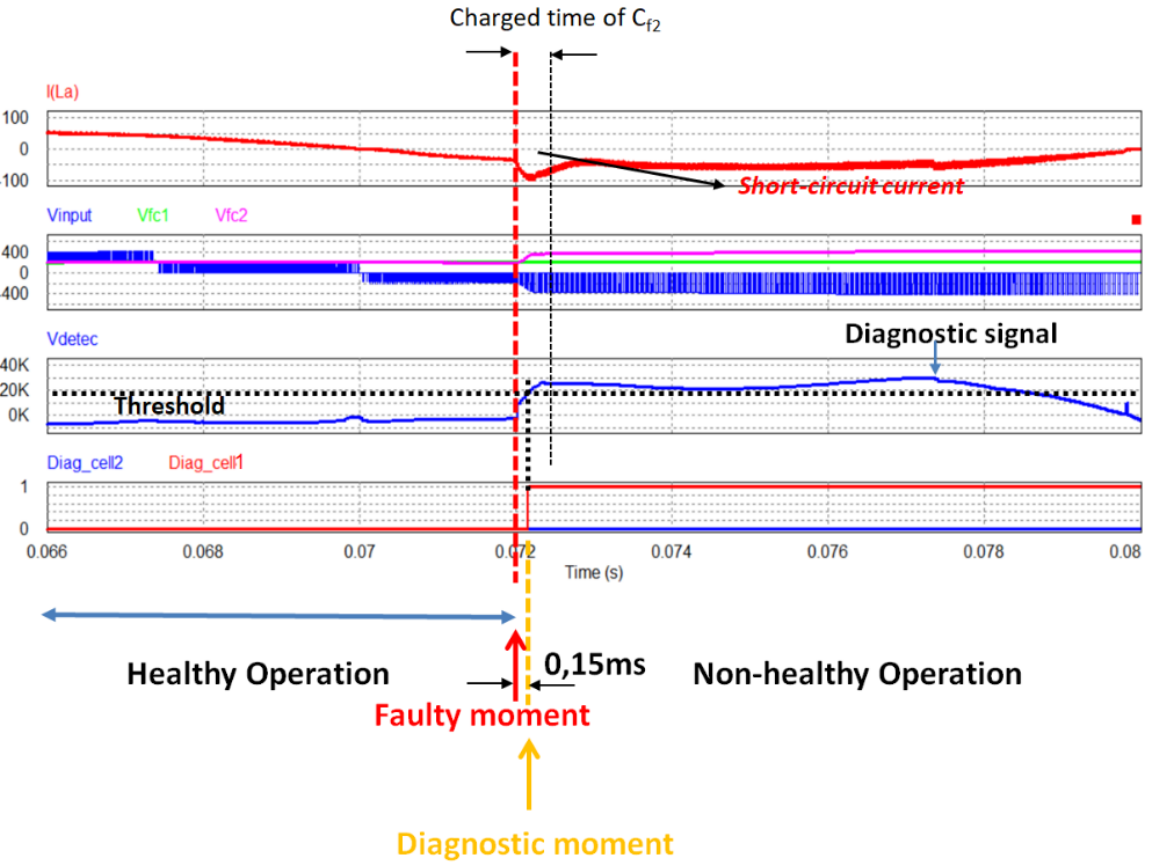
Figure 12. Diagnostic simulation results with a short-circuit on T 1.